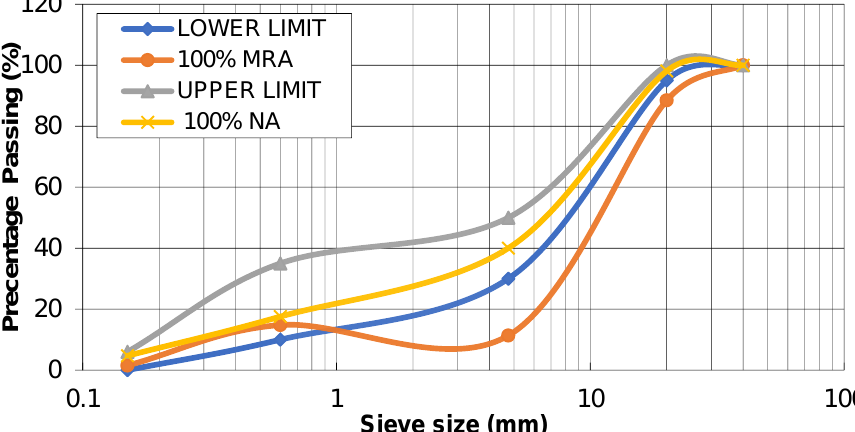
Figure 2. Grain size distribution for all in aggregates.